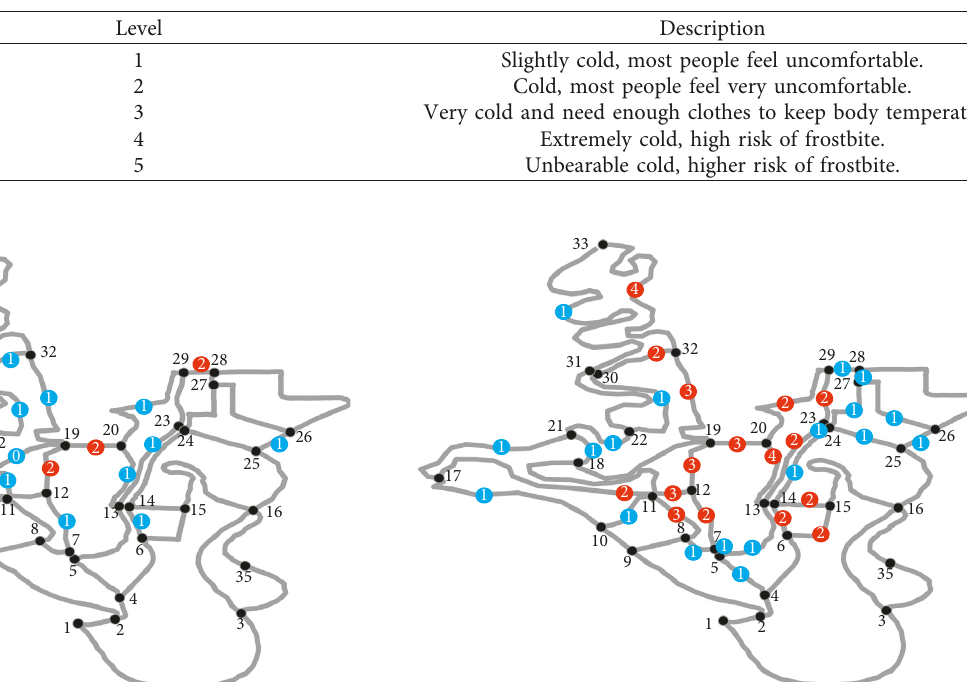
Figure 14: The road network around the Sleigh Center. Table 3: The pedestrian feelings under different cold indexes.